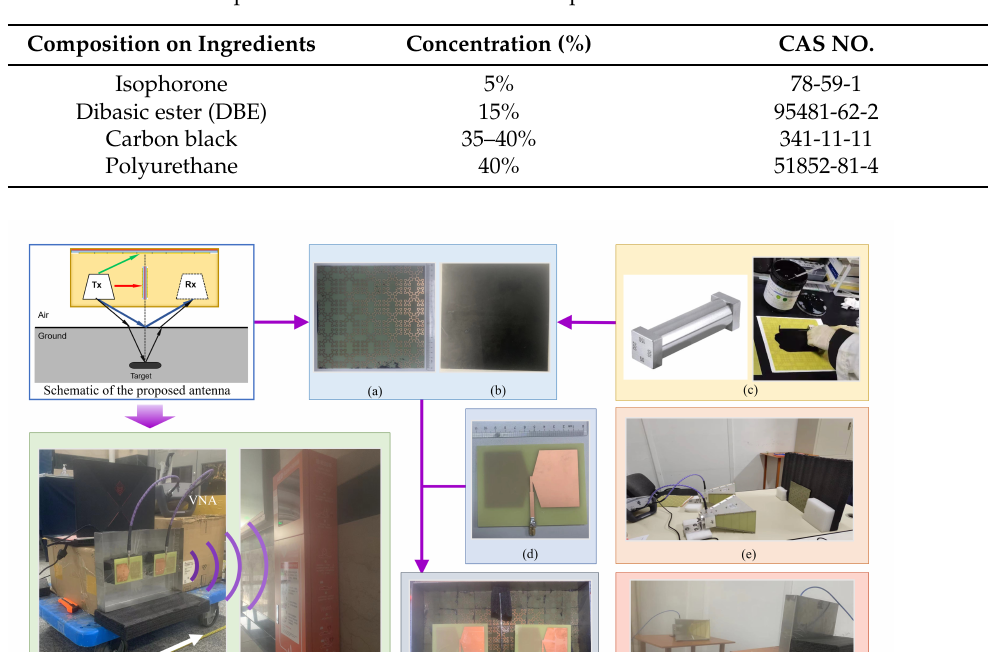
Table 1. The main components of the carbon conductive paste.